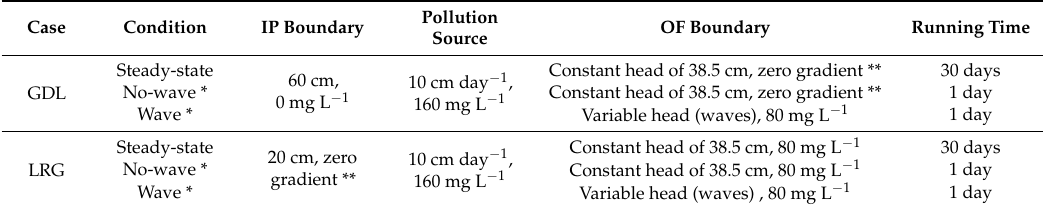
Water flow and solute transport conditions for experiments in the soil flume and in HYDRUS-2D simulations (GDL, groundwater discharge into a lake; LRG, a lake recharging groundwater, IP Boundary, a groundwater boundary in the lakeshore zone; OF Boundary, the lake–groundwater